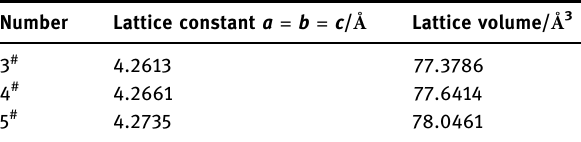
Table 5: Lattice parameters of the product FeO after the second - reduction stage